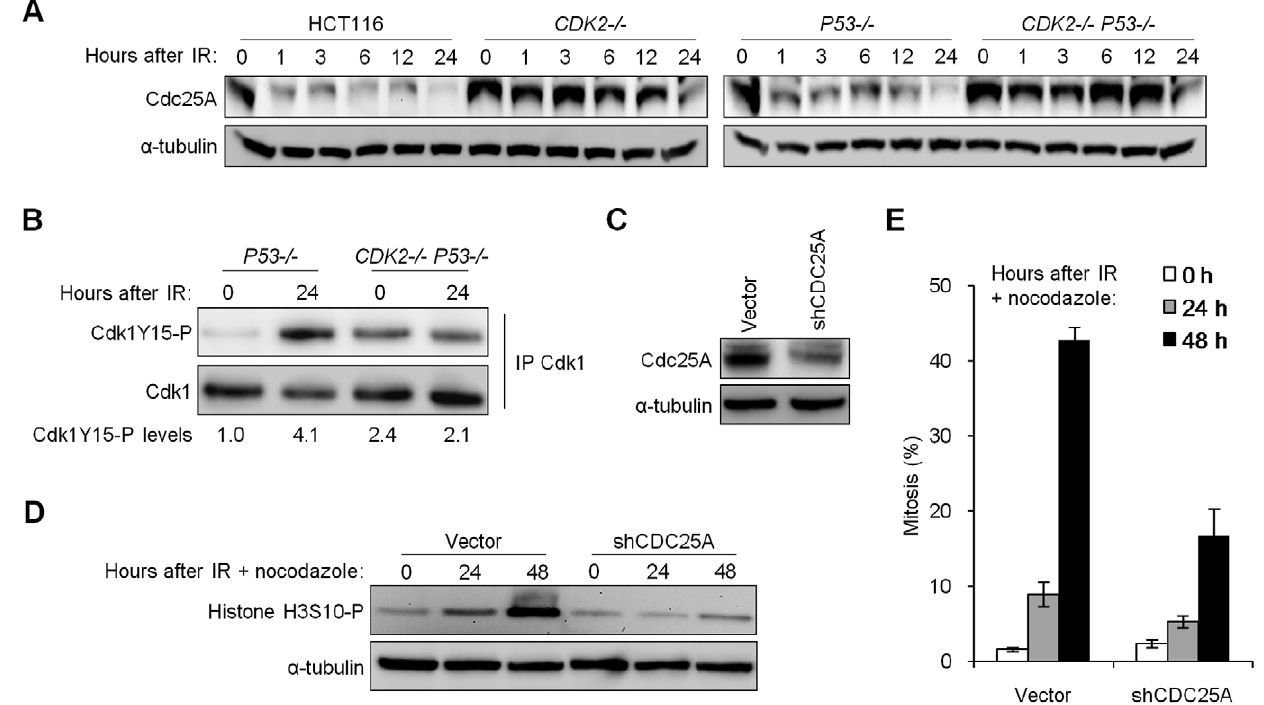
Figure 4. Impaired degradation of Cdc25A in Cdk2-deficient cells contributes to G 2 /M checkpoint defect. (A) Isogenic HCT116 cells were harvested at the indicated times after treatment with 12 Gy IR. Cdc25A levels were determined by immunoblot. (B) Non-denatured cell lysates were collected before and 24 h after 12 Gy IR. Cdk1 was immunoprecipitated (IP) and analyzed for phosphorylation on Y15 by immunoblot. Cdk1Y15- P was quantitated and normalized to total Cdk1. (C) Stable knockdown of Cdc25A in CDK2 2 / 2 P53 2 / 2 cells by retrovirus-mediated delivery of empty vector control (vector) or CDC25A shRNA (shCDC25A), assessed by immunoblot. (D) Cdc25A knockdown or control CDK2 2 / 2 P53 2 / 2 cells were treated with 12 Gy IR and 0.2 m g/ml nocodazole. Histone H3S10-P levels were determined by immunoblot. (E) Mitotic indices of Cdc25A-knockdown and control CDK2 2 / 2 P53 2 / 2 cells at the indicated times after treatment with 12 Gy IR and 0.2 m g/ml nocodazole. Error bars represent s.e.m. from six knockdown clones.